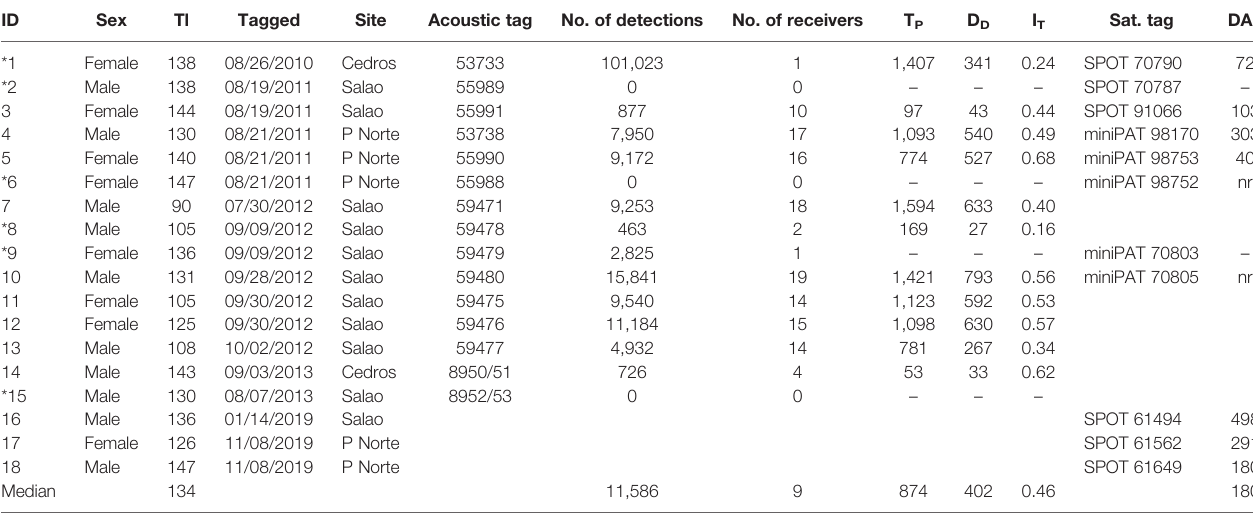
TABLE 1 | Summary data for tagged smooth hammerhead shark Sphyrna zygaena